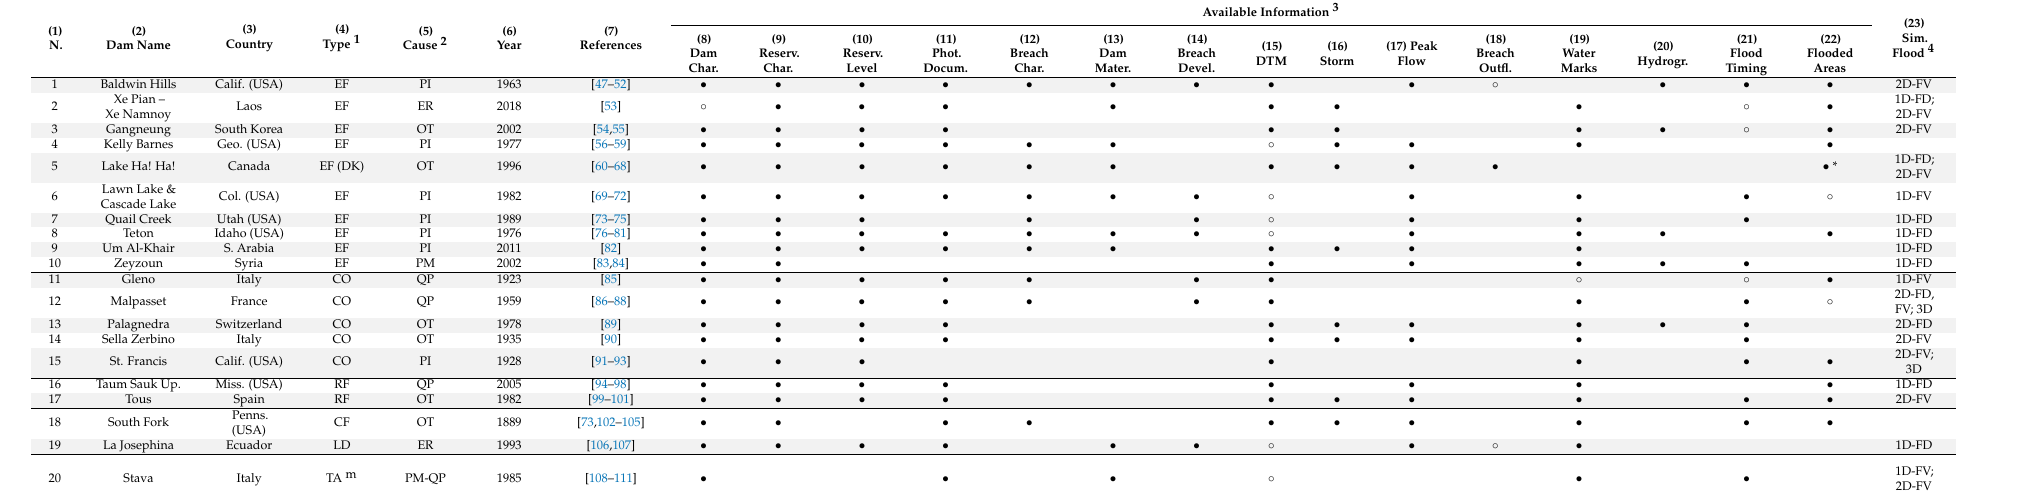
Table 1. Well-documented dam-break test